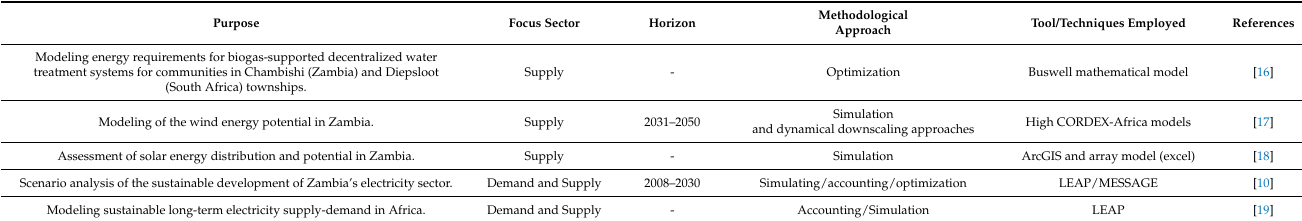
Table 1. Related works on energy modeling in Zambia,